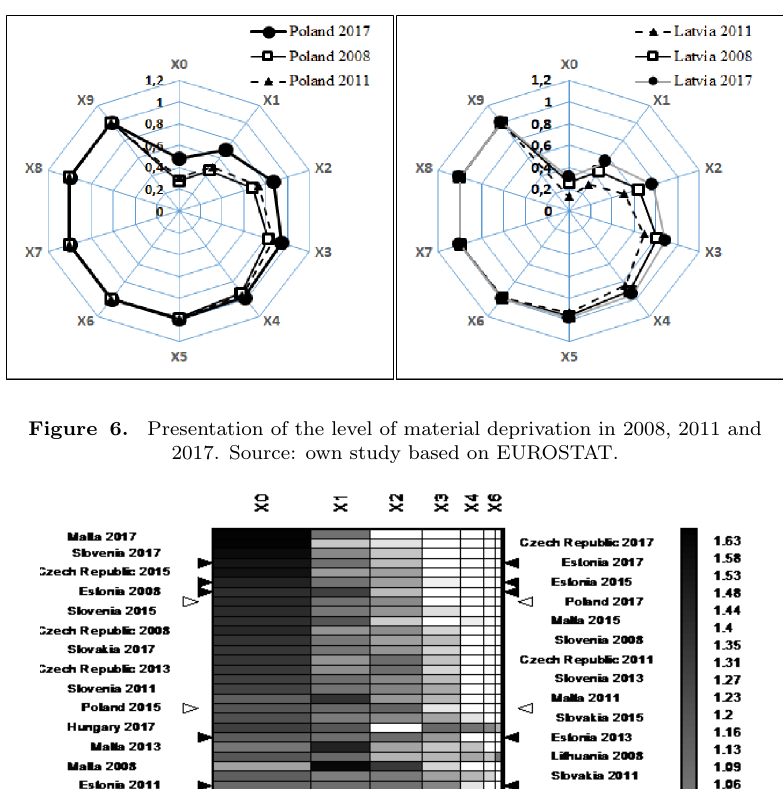
of 12 EU countries in 2008,2011,2013,2015,2017. This structure mean indicator in formula